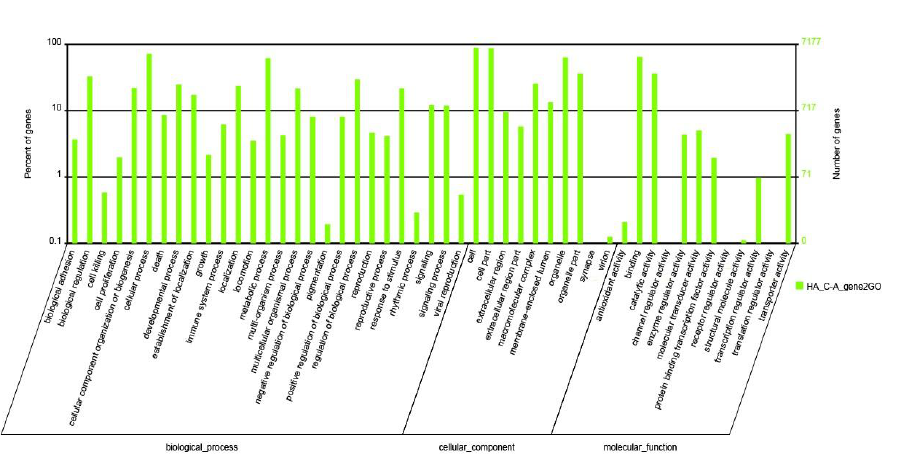
Figure 3. Classification annotation for target genes at Gene Ontology. The figure shows the GO enrichment for the predicted target genes from molecular function, cellular component and biological processes. Approximately 39% of the genes were annotated to cellular component; more than 46% of the genes involved in biological processes and approximately 14% of the genes had molecular functions.